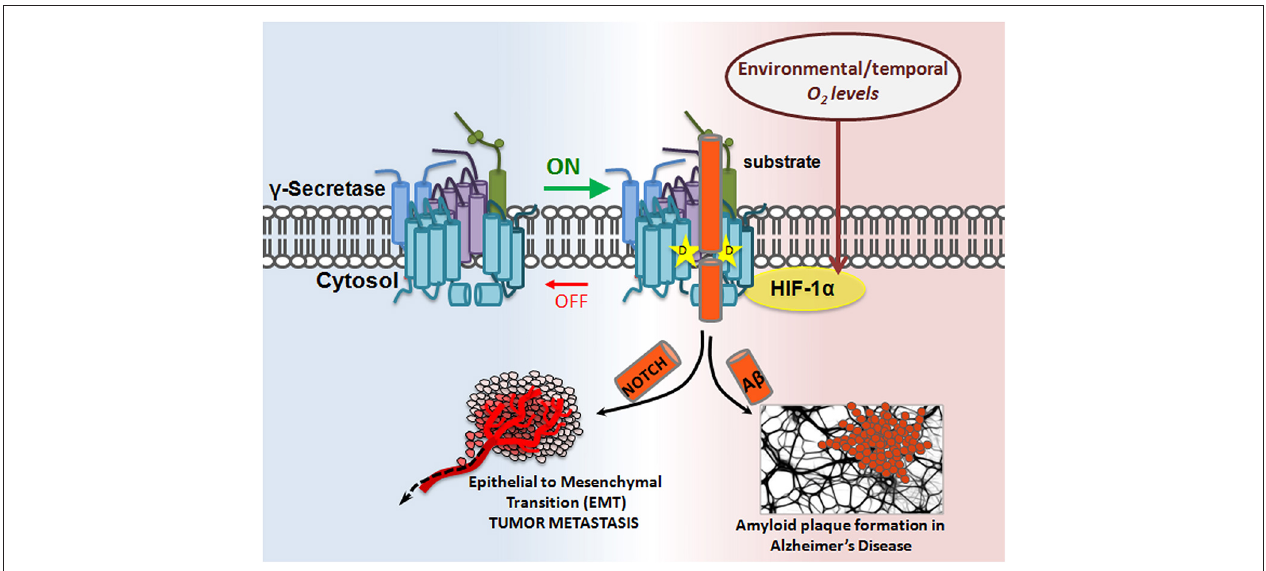
by increasing the ratio of active:inactive γ -secretase complexes in the cell, thereby increasing γ -secretase cleavage of its substrates, such as APP and Notch. The implication is twofold: first, inactive γ -secretase complexes are physiologically important, and second, γ -secretase can be temporally